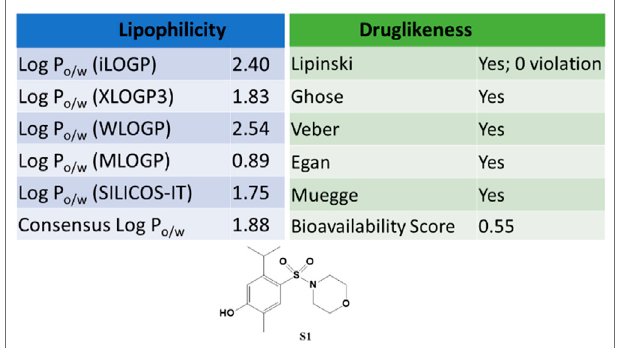
FIGURE 12 | Medicinal Chemistry and pharmacokinetics for S1 . These parameters were generated online using